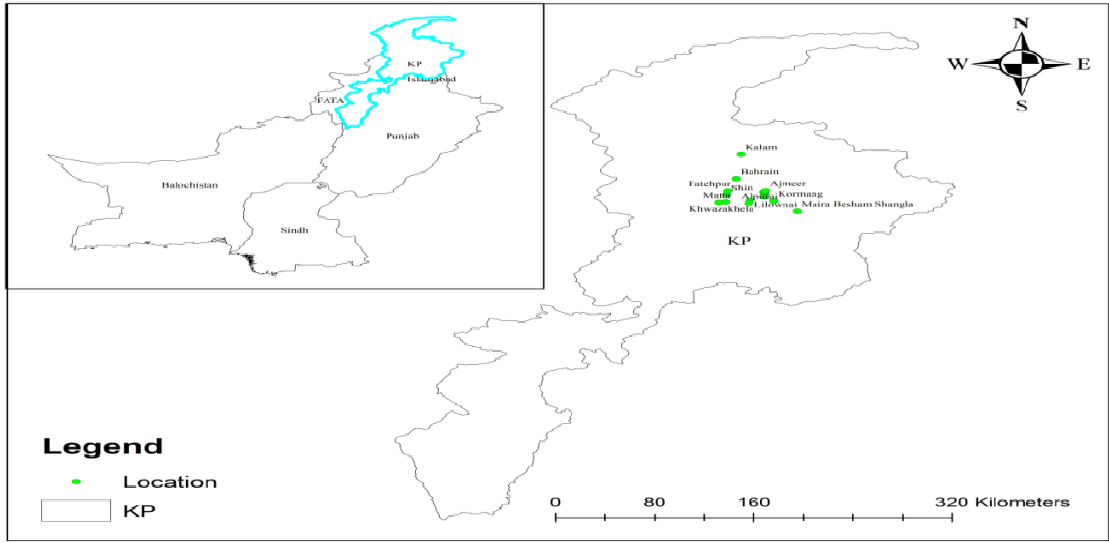
Figure 1. Study area map.